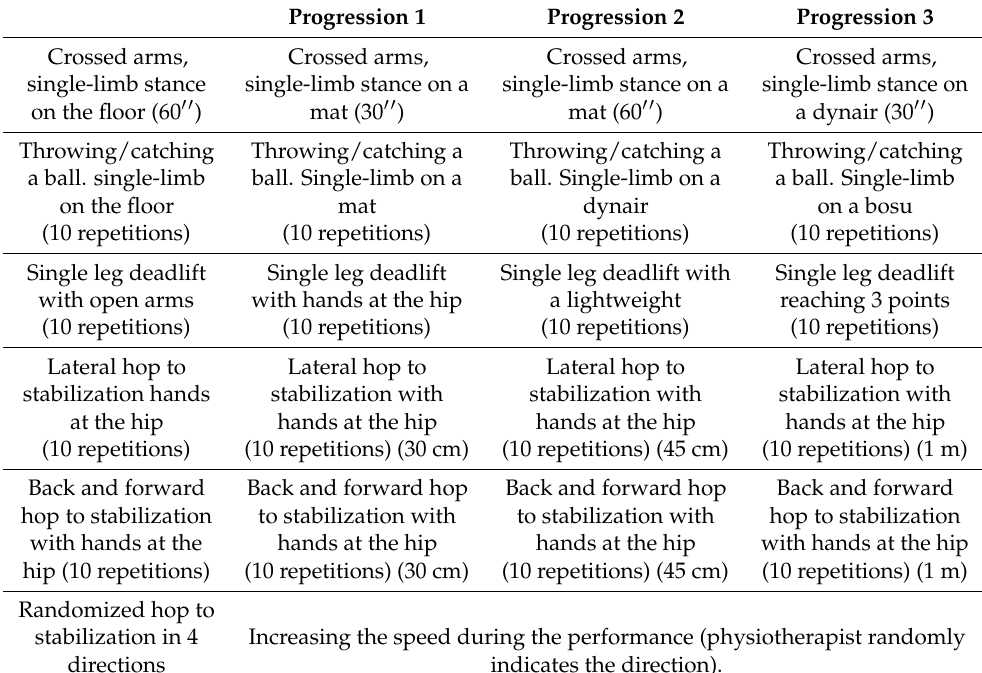
Table 2. Intervention protocol and